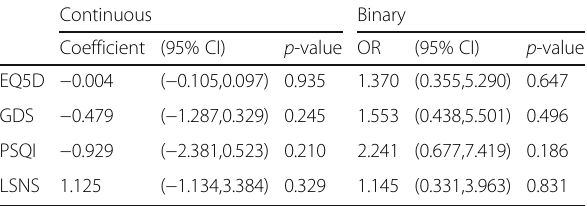
Values shown have been adjusted for order and period effect Abbreviations : OR Odds Ratio, CI Confidence Interval, EQ5D European Quality of Life-5 Dimensions, GDS Geriatric Depression Scale, PSQI Pittsburg Sleep Quality Index, LSNS Lubben Social Network Scale, ADL Activities of Daily